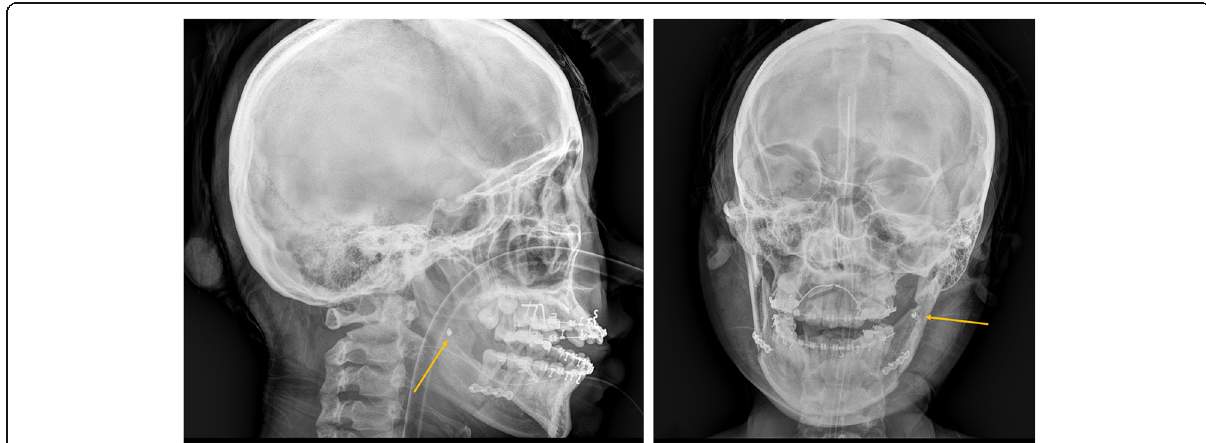
Fig. 8 Failed brackets (arrows) are investigated in the operating room using intraoperative radiographic images ( a lateral; b frontal